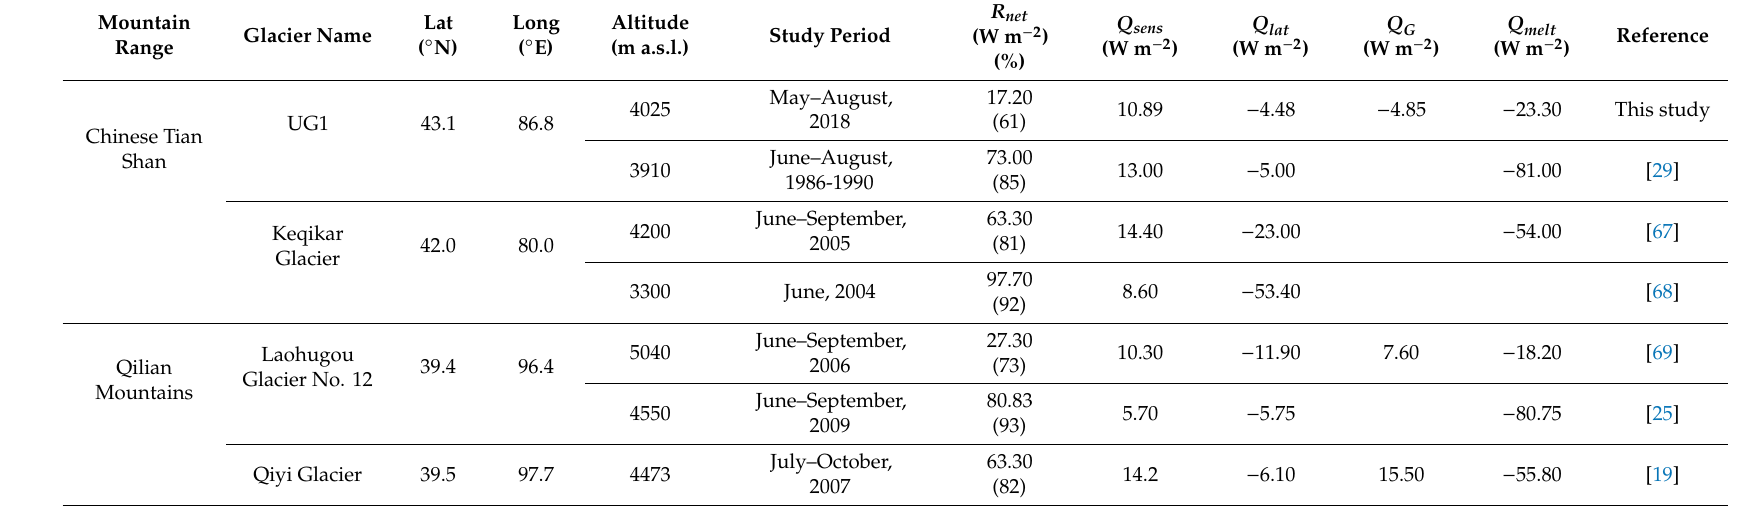
Table 6. Comparison of energy components of UG1 with other continental glaciers in northwest